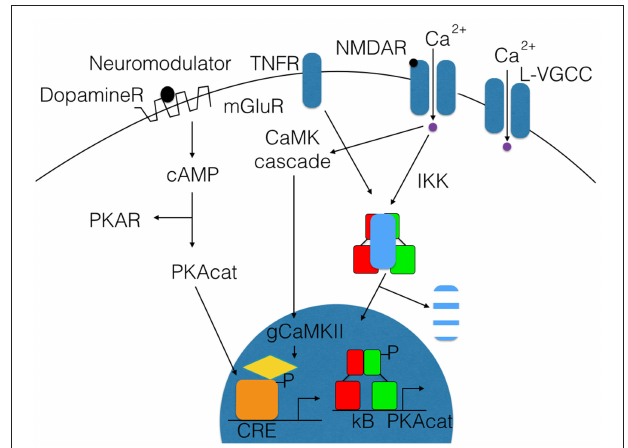
FIGURE 2 | Schematic representation for the activation of transcription factors like NF- κ B and CREB by synaptic activity. Upon synaptic stimulation of the receptors for NMDA or voltage-gated calcium channels (L-VGCC), a calcium influx induces activation of IkB kinases and phosphorylation of IkB (blue). Finally, degradation within the proteasome takes place, and thereby the nuclear localization signal of NF-kB is unmasked and allows NF- κ B (red/green) to enter the nucleus, where it binds to kb sites and activates the transcription of target genes like PKAcat (catalytic subunit of protein kinase A). On the left site, CREB is activated after stimulation of mGluR or dopamine receptors by dopamine, and cAMP increases activating PKA. This phosphorylates the transcription factor CREB and other proteins like MAP kinases. P-CREB (orange) is bound by CBP (yellow), which initiates the transcription of its target genes. Interestingly, activation of NF- κ B and expression of its target gene PKAcat will induce a positive feed-forward loop to CREB activation without additional synaptic activation, which might explain the late phase of long-term